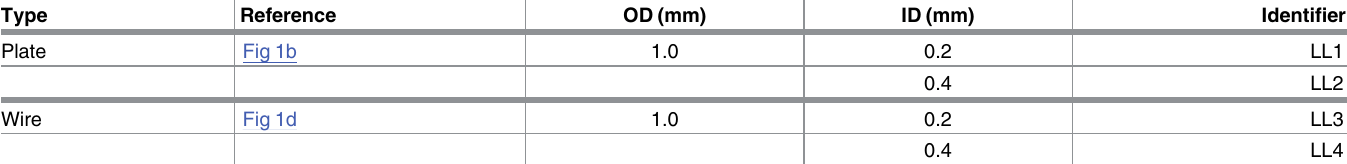
Table 1. Overview of the four different double Lenz lens variants